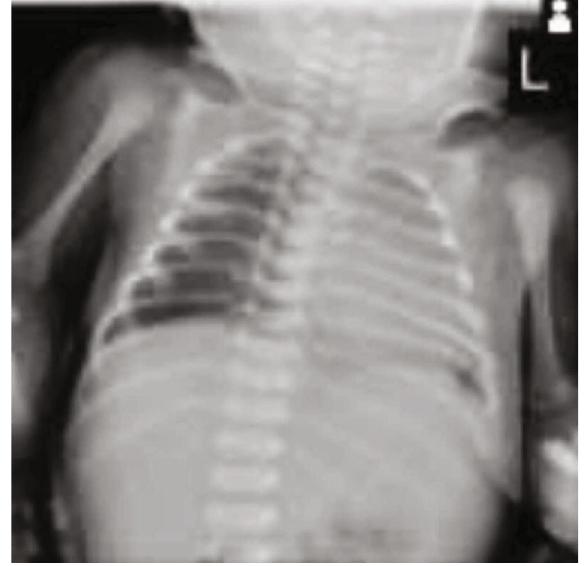
Figure 2: Chest radiograph of the newborn with diagnosis of transient tachypnea of the newborn